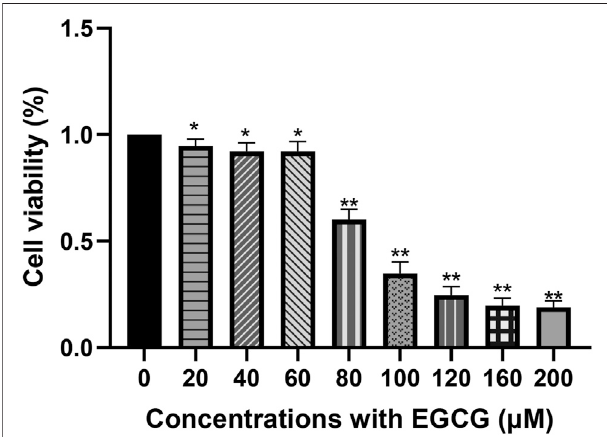
FIGURE 1 | Cell viability of A549 cells after EGCG exposure. A549 cells wereexposedto20 – 200 μ MEGCGfor24 h,andcellviabilitywasdetermined utilizing a CCK-8 assay. The experimental data are expressed as the mean value with SD of three independent replicates. (* p < 0.05, ** p <